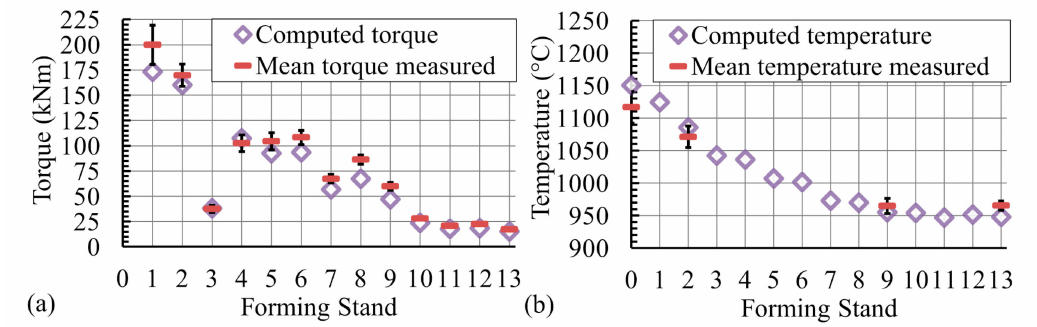
Figure 3. ( a ) Computed torques and ( b ) computed skin temperature versus measurements on an industrial rolling mill. The temperature of the forming stand 0 corresponds to the initial temperature just before stand 1.